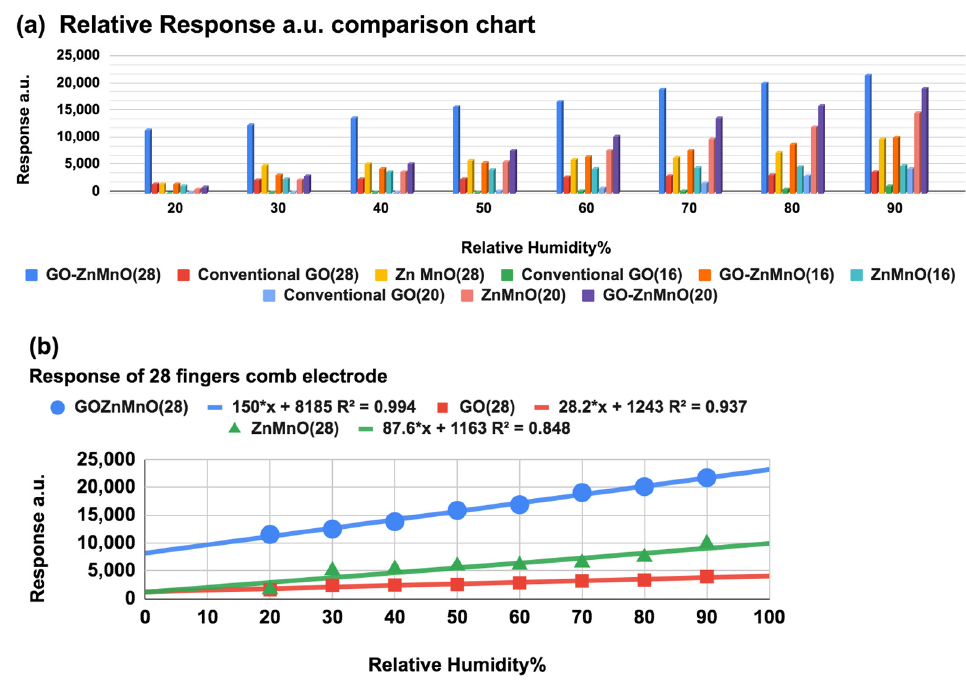
Figure 6. ( a ) Response comparison chart for GO, Mn x Zn 1 − x O, and GO-Mn x Zn 1 − x O on 28-, 20-, and 16-finger combs. ( b ) Specific 28-finger comb response with a linear fit.